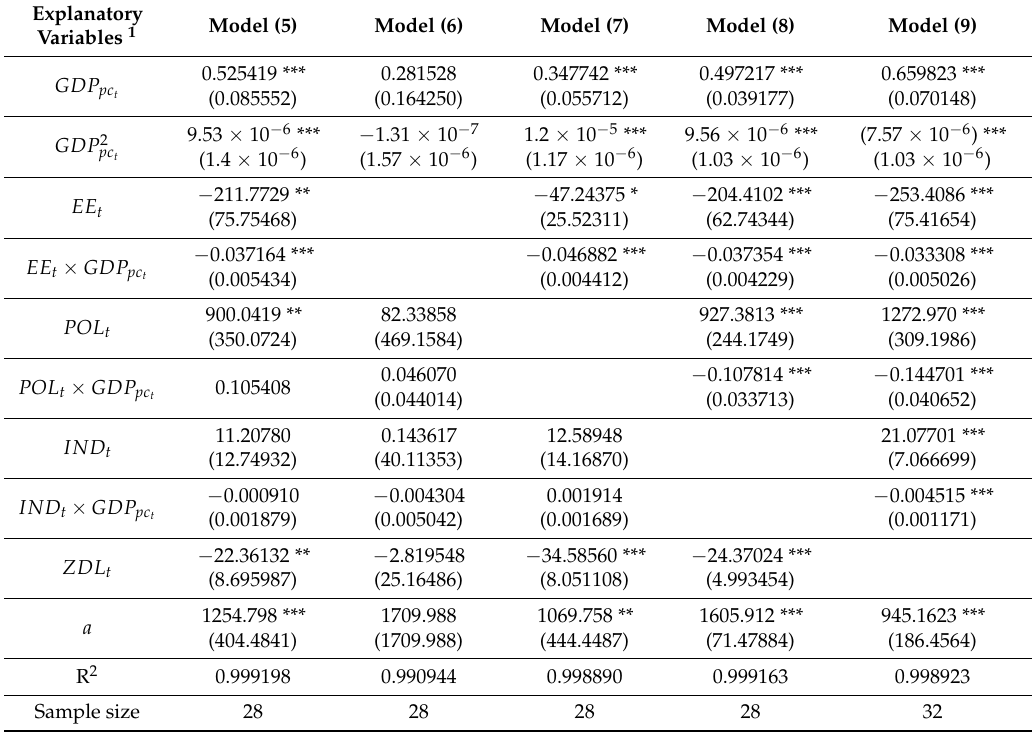
Table 4. Comparison of Models